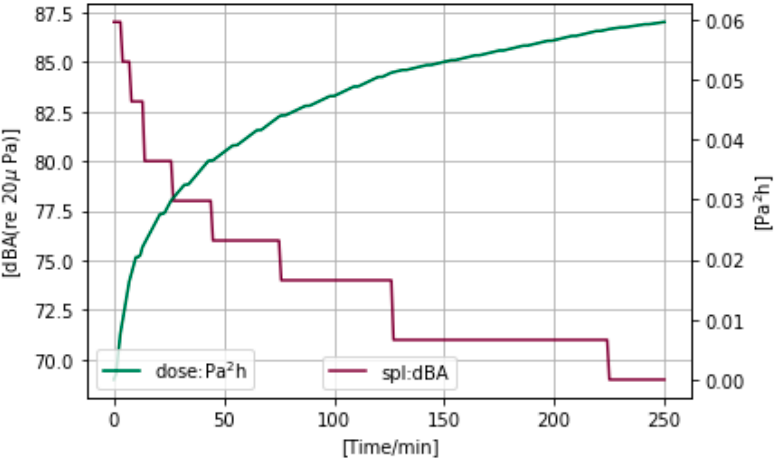
Figure 6. SPL suppression with growing Dose. With the growth of the accumulated Dose, the time spent at the target volume grows longer, which is good for the user’s listening